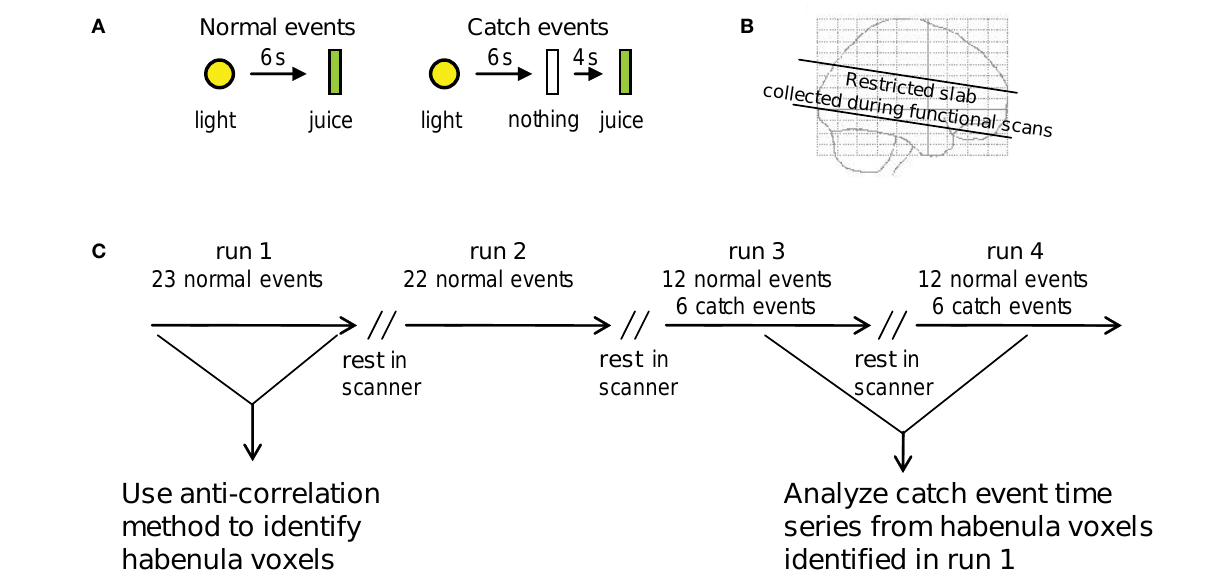
22 normal events in run 2, 12 normal events and 6 catch events in run 3, and 12 normal events and 6 catch events in run 4 (the total number of catch events was kept low to avoid learning). During the periods labeled “rest”, functional imaging was halted and subjects ( n = 50) were asked about comfort and their capacity to continue the task before imaging continued. No change in subject position occurred during rest periods. Run 1 was used to identify the habenula voxels using functional and anatomical criteria (see Figure 